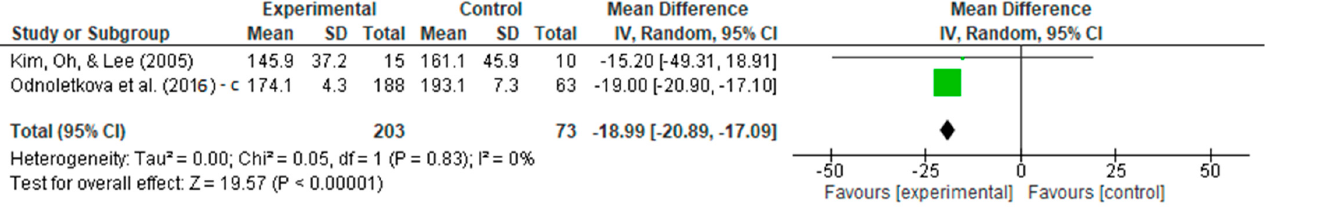
Figure 6. Forest plot intervention vs. control of telecoaching in achieving a blood glucose outcome [16,21].